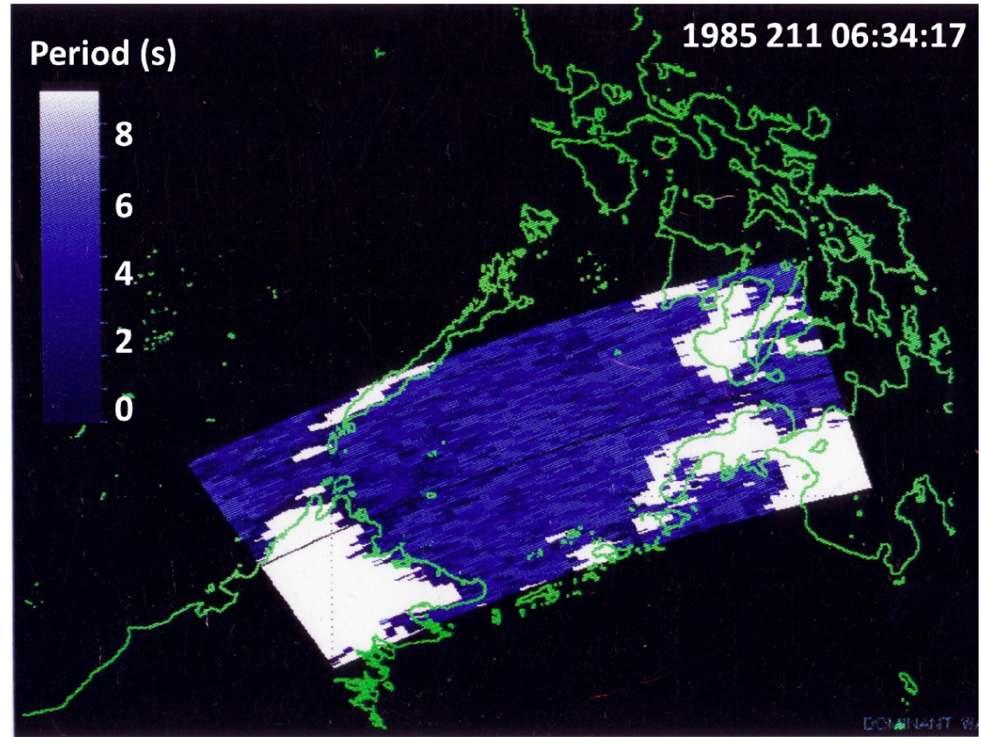
Figure 17. A skywave radar map of the dominant wave period in the Sulu Sea. Note the displacement of the land echoes (shown in white) from the map outline; this is a result of tilts in the ionosphere.